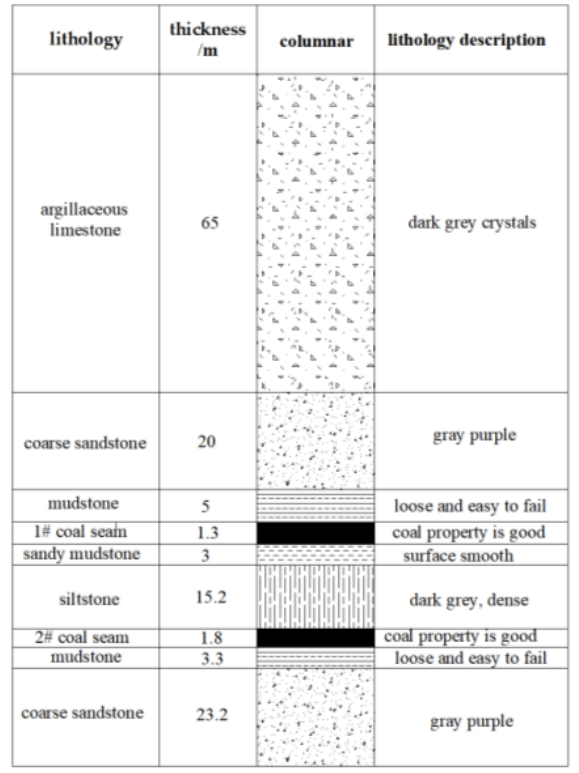
Figure 1. Integrated histogram of coal seam D.